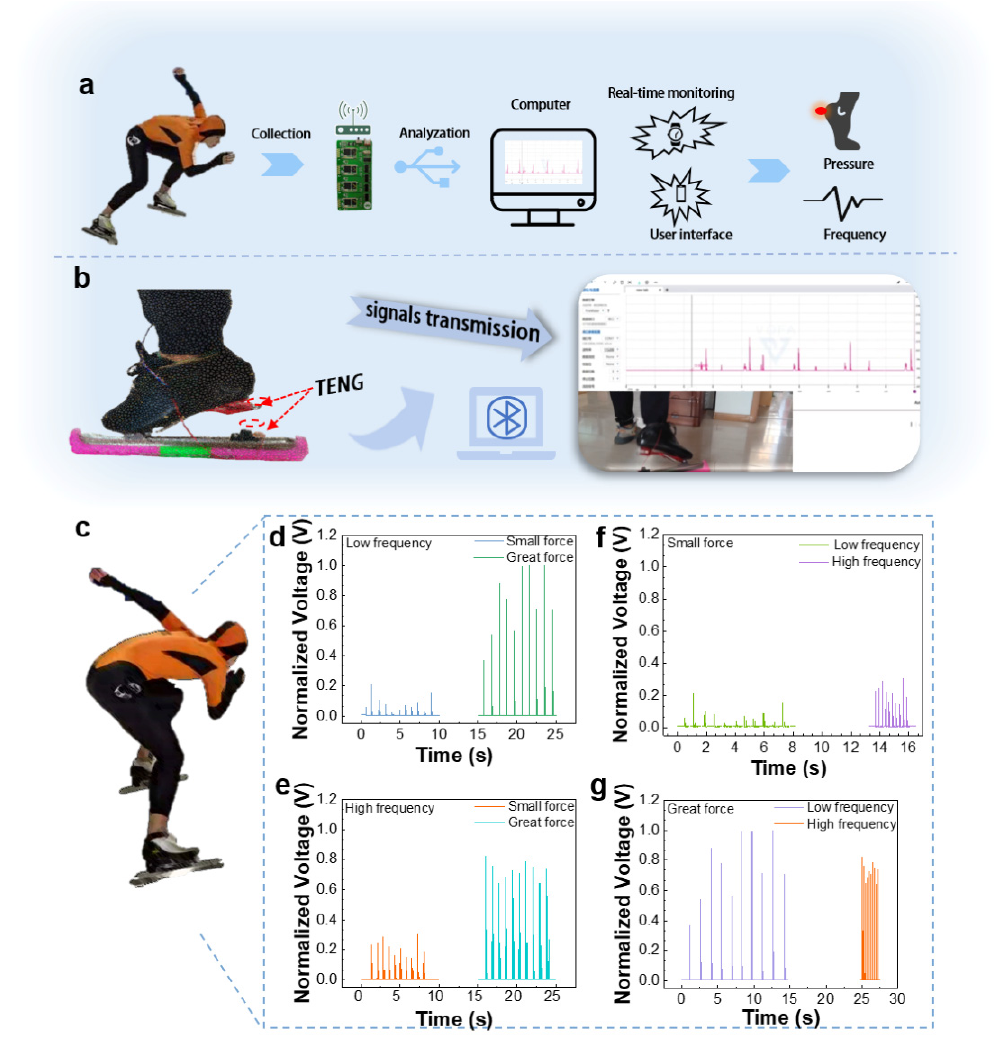
Figure 4. Actual test of the LPS-TENG signal wireless transmission system. ( a ) The working process of the wireless transmission system of the LPS-TENG signal. ( b ) The LPS-TENG generates voltage signal in real-time when the tester is exercising. ( c – g ) Normalized voltage generated by the LPS-TENG under different pedaling frequencies and pedaling forces.